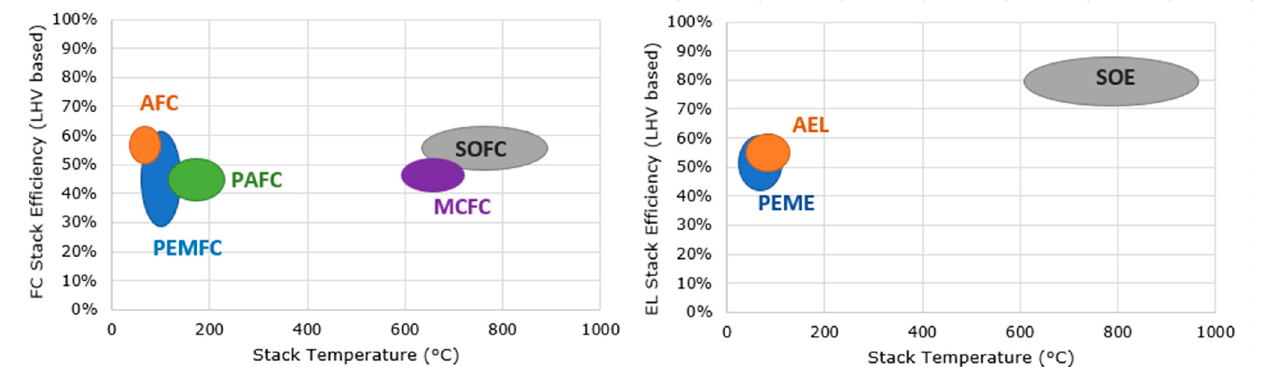
Figure 1. Fuel cells ( left ) and electrolysers ( right ): stack efficiency vs. operative temperature [4] for alkaline electrolysers (AEL) alkaline fuel cells (AFC), molten carbonate fuel cells (MCFC), phosphoric acid fuel cells (PAFC), polymer membrane electrolysis membranes (PEME), polymer membrane fuel cells (PEMFC), solid oxide electrolysers (SOE), solid oxide fuel cells (SOFC).